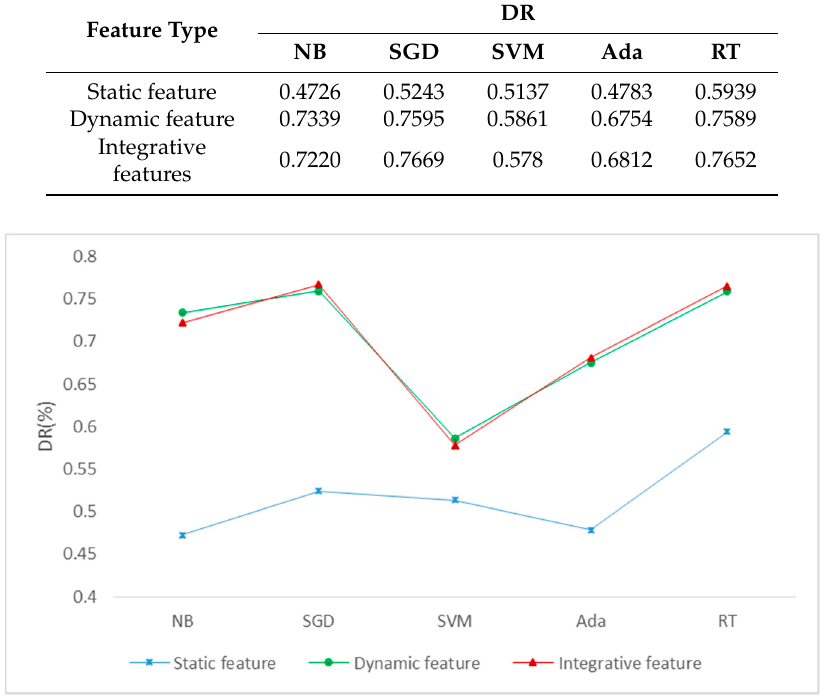
Table 8. The obfuscated-detection results of models trained by different types of features. DR (Detection Rate, DR), NB (Naive Bayes, NB), SGD (Stochastic Gradient Descent, SGD), SVM (Support Vector Machine, SVM), Ada (Adaboost, Ada) and RT (Random Trees, RT).